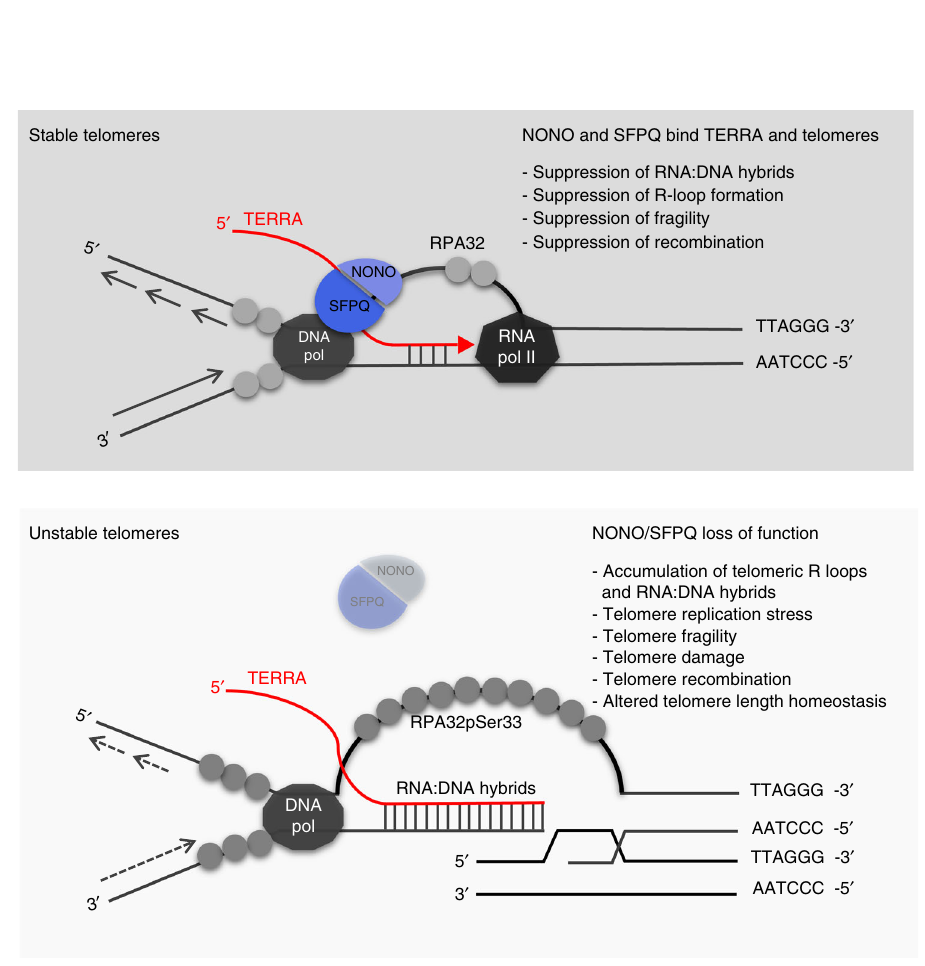
Fig. 7 A model for the role of NONO and SFPQ in controlling telomere stability. Top panel: NONO and SFPQ bind TERRA transcripts at telomeres and control mechanisms that antagonize the accumulation of RNA:DNA hybrids, thereby stabilizing telomeres. Bottom panel: Loss of NONO and SFPQ leads to the accumulation of RNA:DNA hybrids at telomeres, resulting in the displacement of the non-template telomere strand (G-strand) and R-loop formation. Increased R-loop formation triggers replication defects, fragility, telomere damage and the exposition of recombinogenic telomeric DNA that engage in telomere recombination events and result alterations in telomere length homeostasis. DNA pol, DNA polymerase; RNA pol II, RNA polymerase